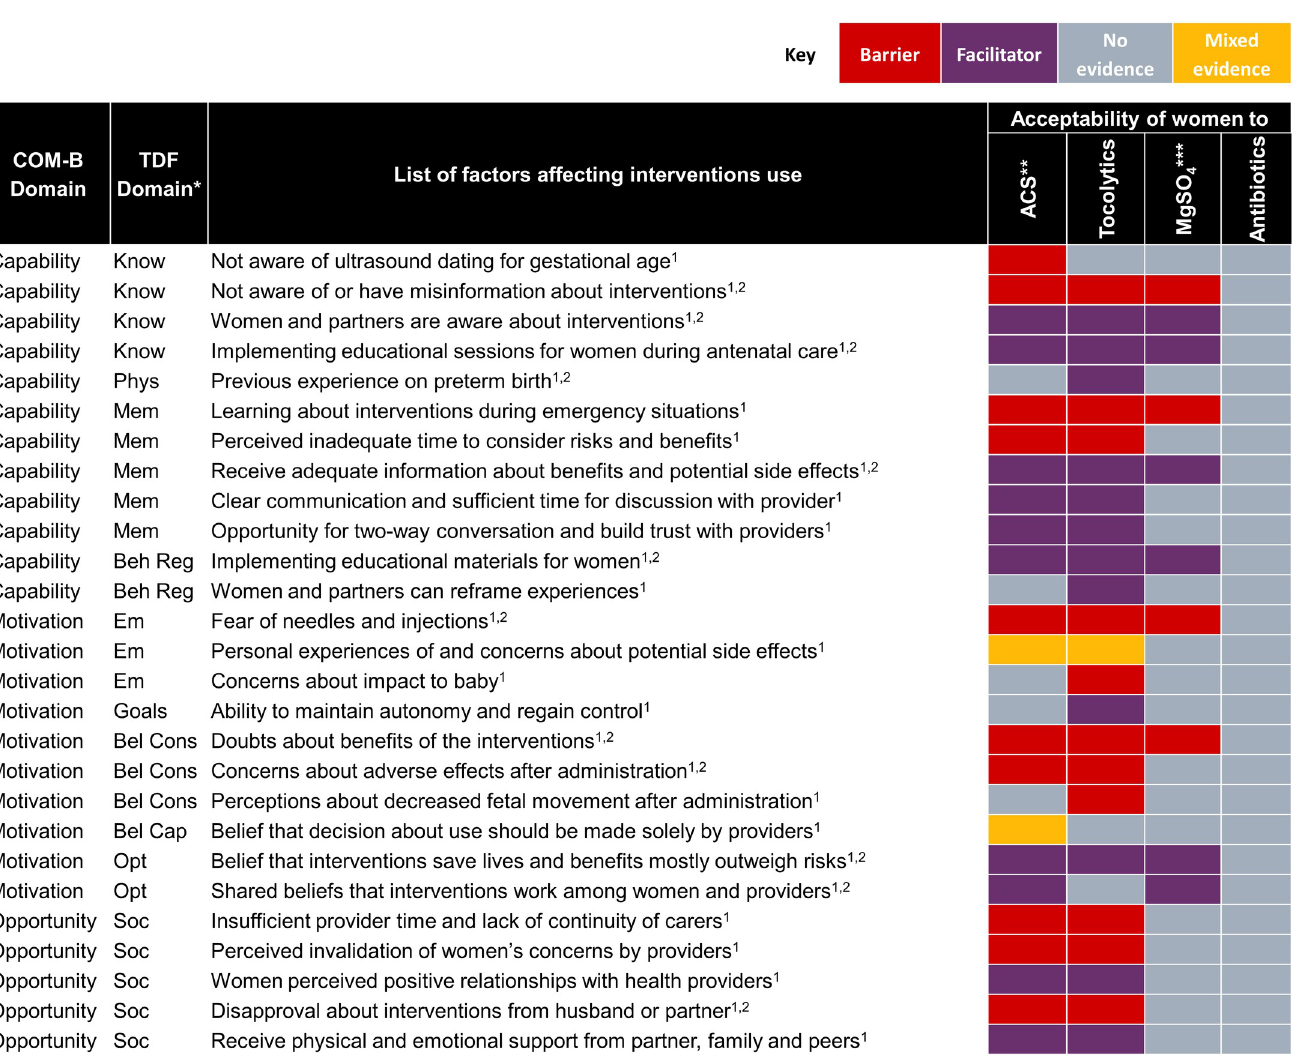
Fig 5. TDF and COM-B mapping on factors affecting acceptability of women to use ACS, tocolytics, magnesium sulphate, and antibiotics. � Know, Knowledge; Phys, Physical skills; Mem, Memory, attention, and decision processes; Beh Reg, Behavioural regulation; Em, Emotion; Id, Social/professional role and identity; Bel Cons, Belief about consequences; Bel Cap, Belief about capabilities; Int, Intentions; Opt, Optimisms; Ev, Environmental context and resources. �� ACS; ��� Magnesium sulphate. 1 Factor identified from qualitative evidence. 2 Factor identified from quantitative